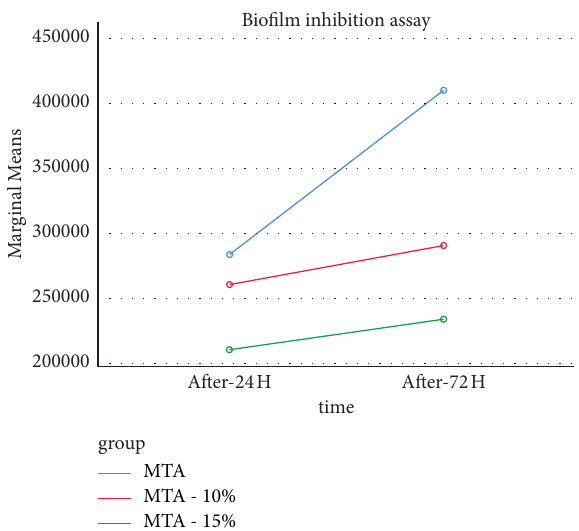
Figure 4: The linear graph of the comparison of the groups with the BIA